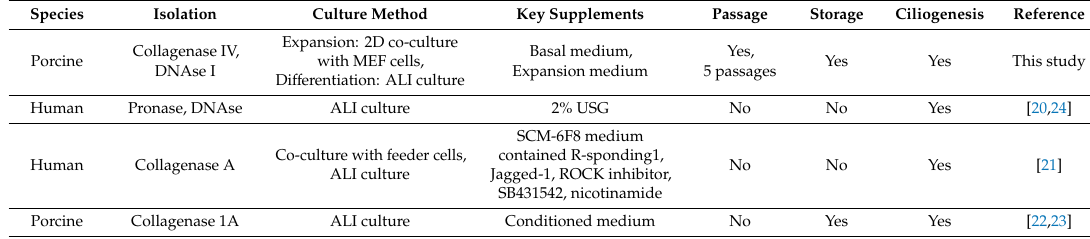
Table 1. Comparison of di ff erent culture systems of